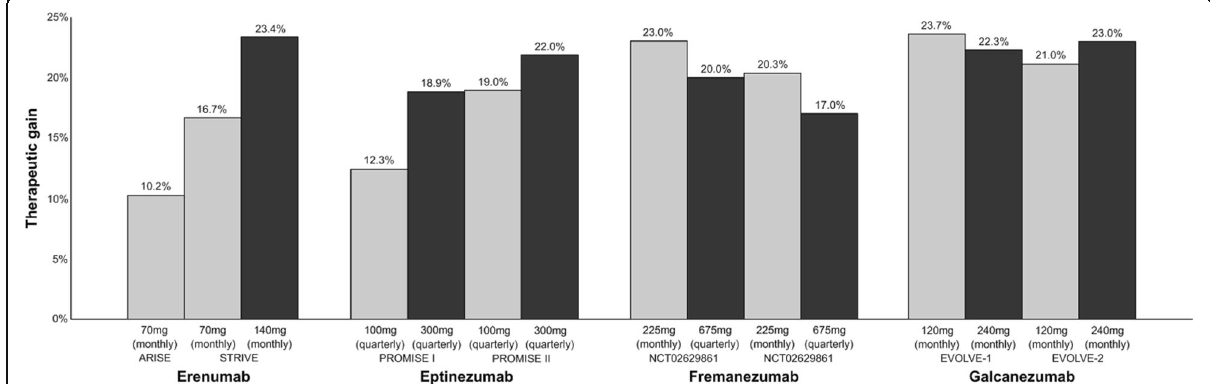
Fig. 11 Overview of the therapeutic gain* in percentage of patients with > 50% reduction in migraine days with anti-calcitonin gene-related peptide monoclonal antibodies. A darker bar indicates a higher dose. *Therapeutic gain is defined as the difference between percentage of patients in active group compared to percentage of patients in placebo group